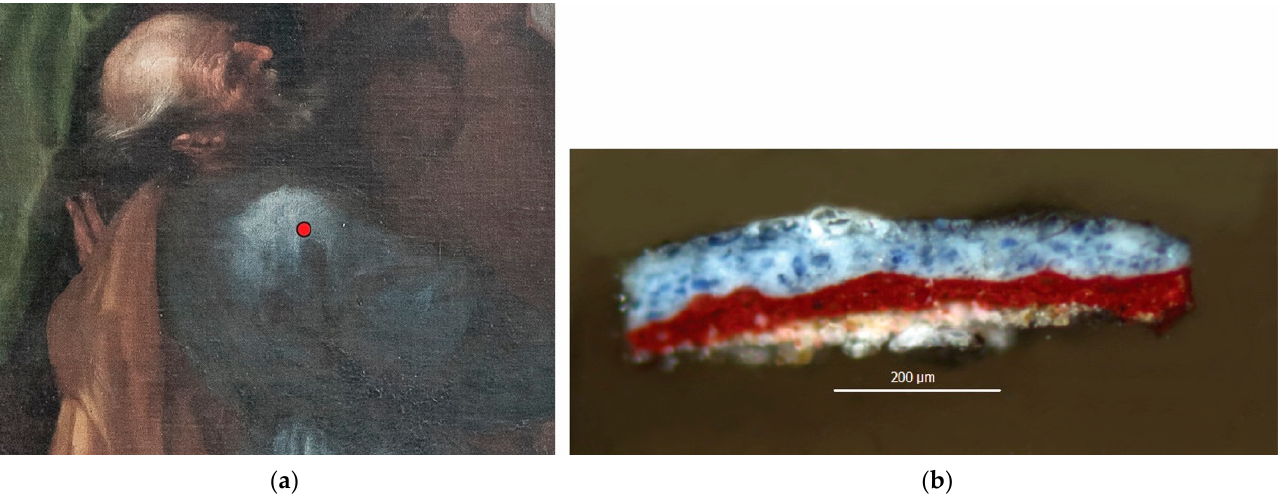
Figure 6. ( a ) Detail of the Saint’s blue garment in La Asunción . The area the sample was taken from is marked with a red dot. Detail of photograph by: Gerardo Hernández Rosales. Reproduction authorized by the Instituto Nacional de An- tropología e Historia. ( b ) Cross-section under an optical microscope (10×). Image by LADiPA-COLMICH.